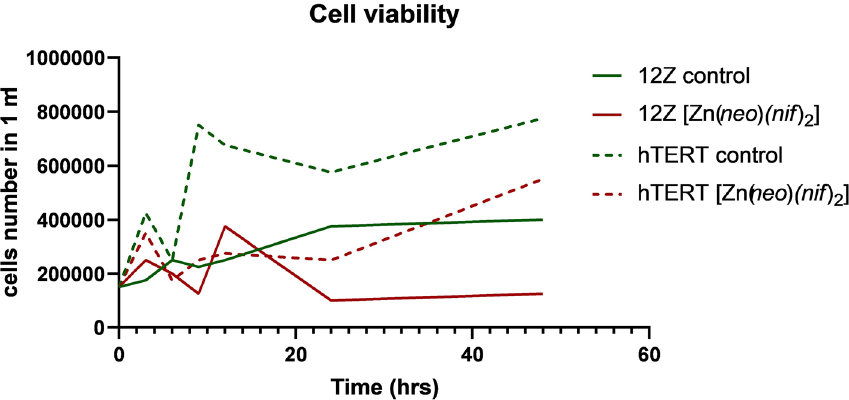
Figure 6. Cell viability of non-endometriotic hTERT cells and endometriotic 12Z cells with and without Zn-Nif